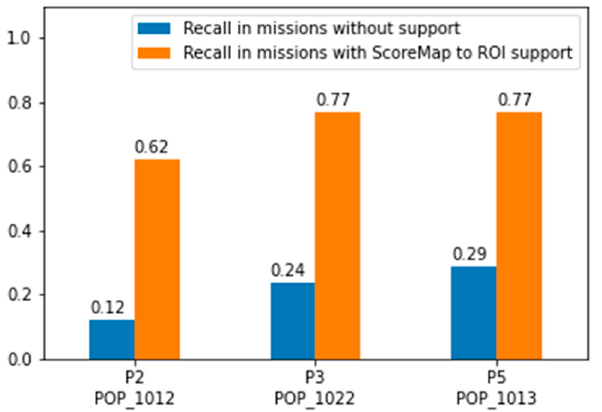
Figure 21. Comparison of the most difficult examples (the least detected persons) in missions (mission Popovo polje 1) without and with the ScoreMap to ROI support.